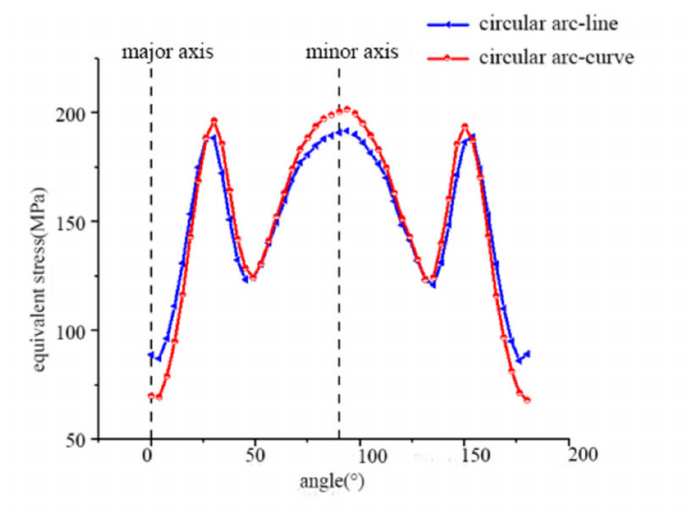
Figure 10. Comparative curve of equivalent